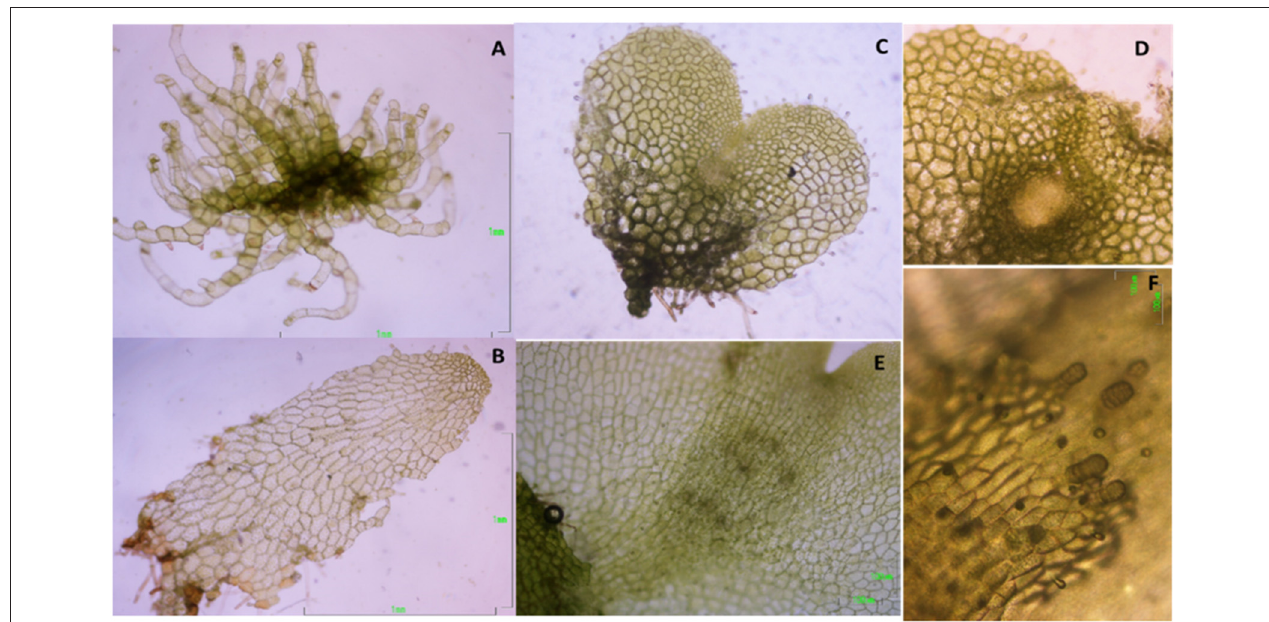
FIGURE 1 | Morphological features in the growth stages of the apogamous fern Dryopteris affinis : (A) filamentous; (B) spatulate; (C) cordate or heart-shaped; (D) detail of first steps in the embryo development; and its sexual relative D. oreades : (E) archegonium cushion in the middle of gametophyte; (F) archegonia.